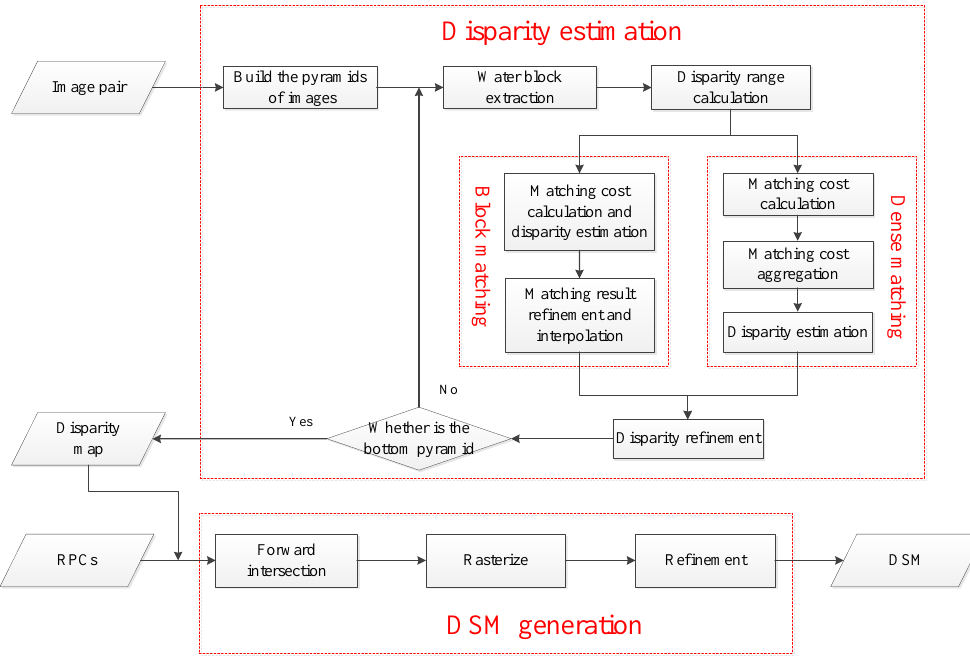
Figure 2. Flowchart of SGBM.